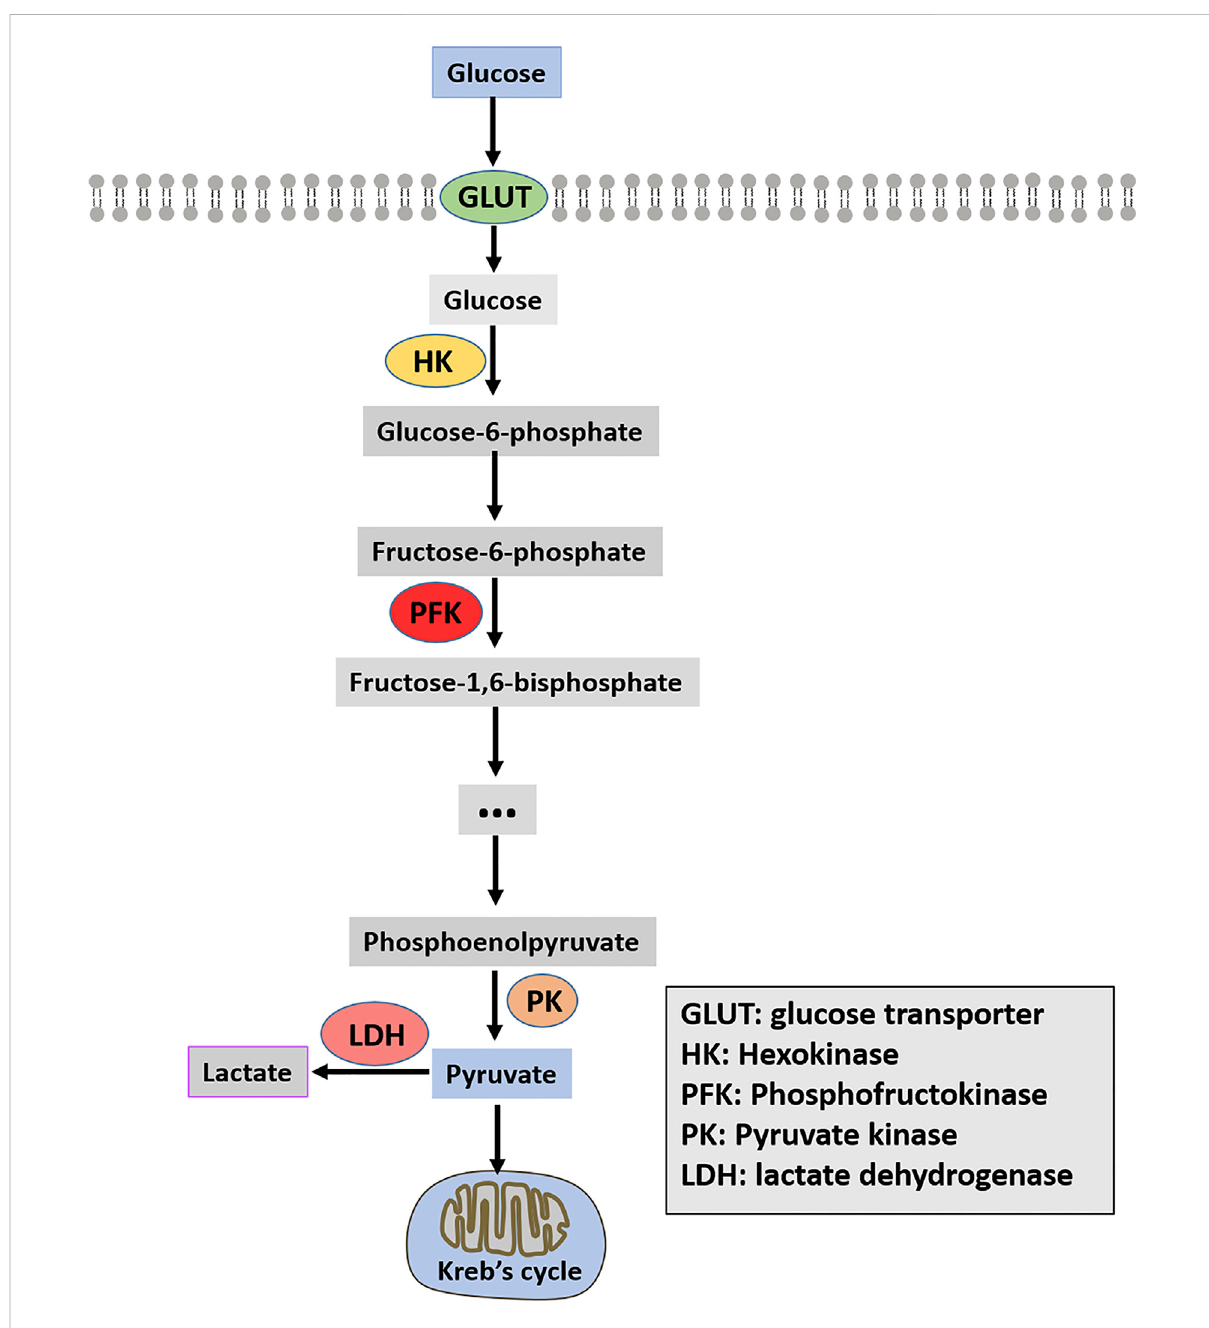
FIGURE 1 Schematic diagram of